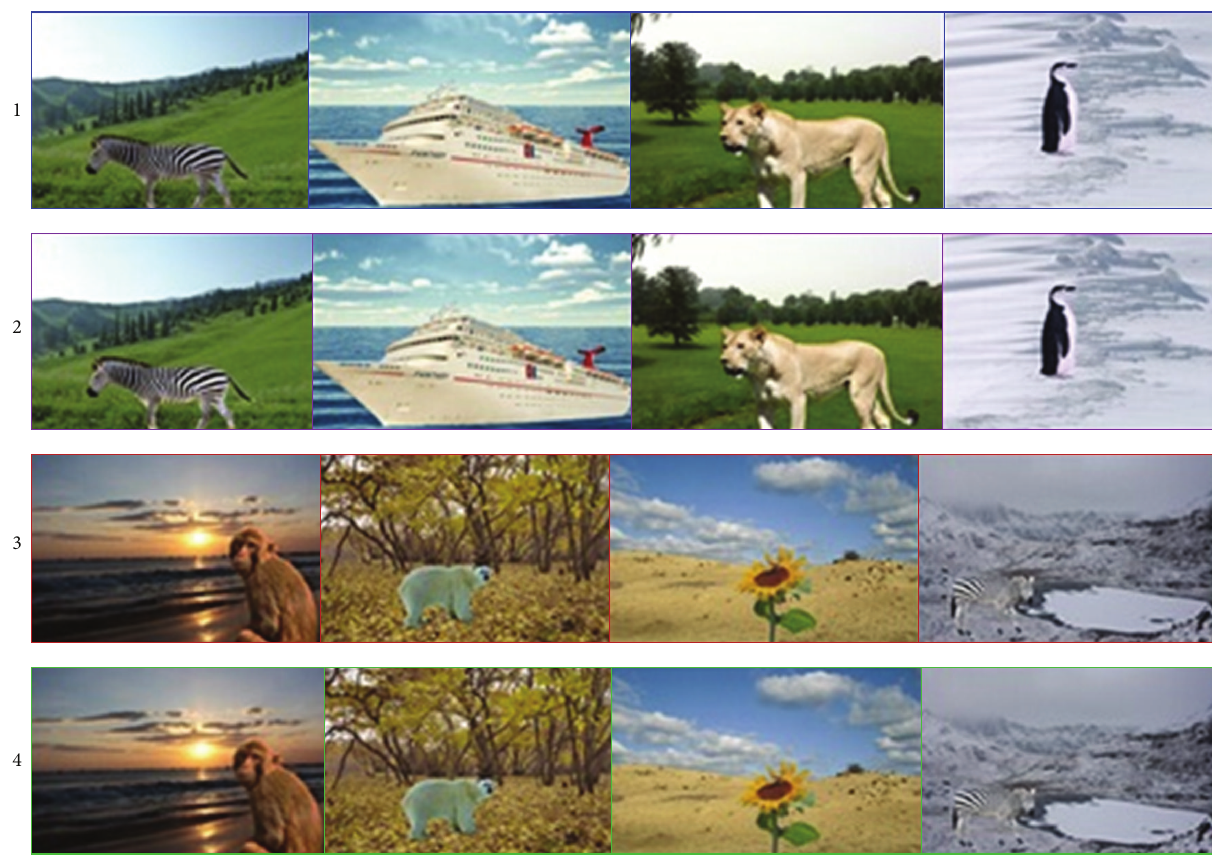
Figure 9: Results of scene consistency verification. Row 1 and row 3 are results of our experiments and row 2 and row 4 are results of literature [5]. The border color indicates the verification result for each image (blue and green: scene is consistent; red and purple: scene is